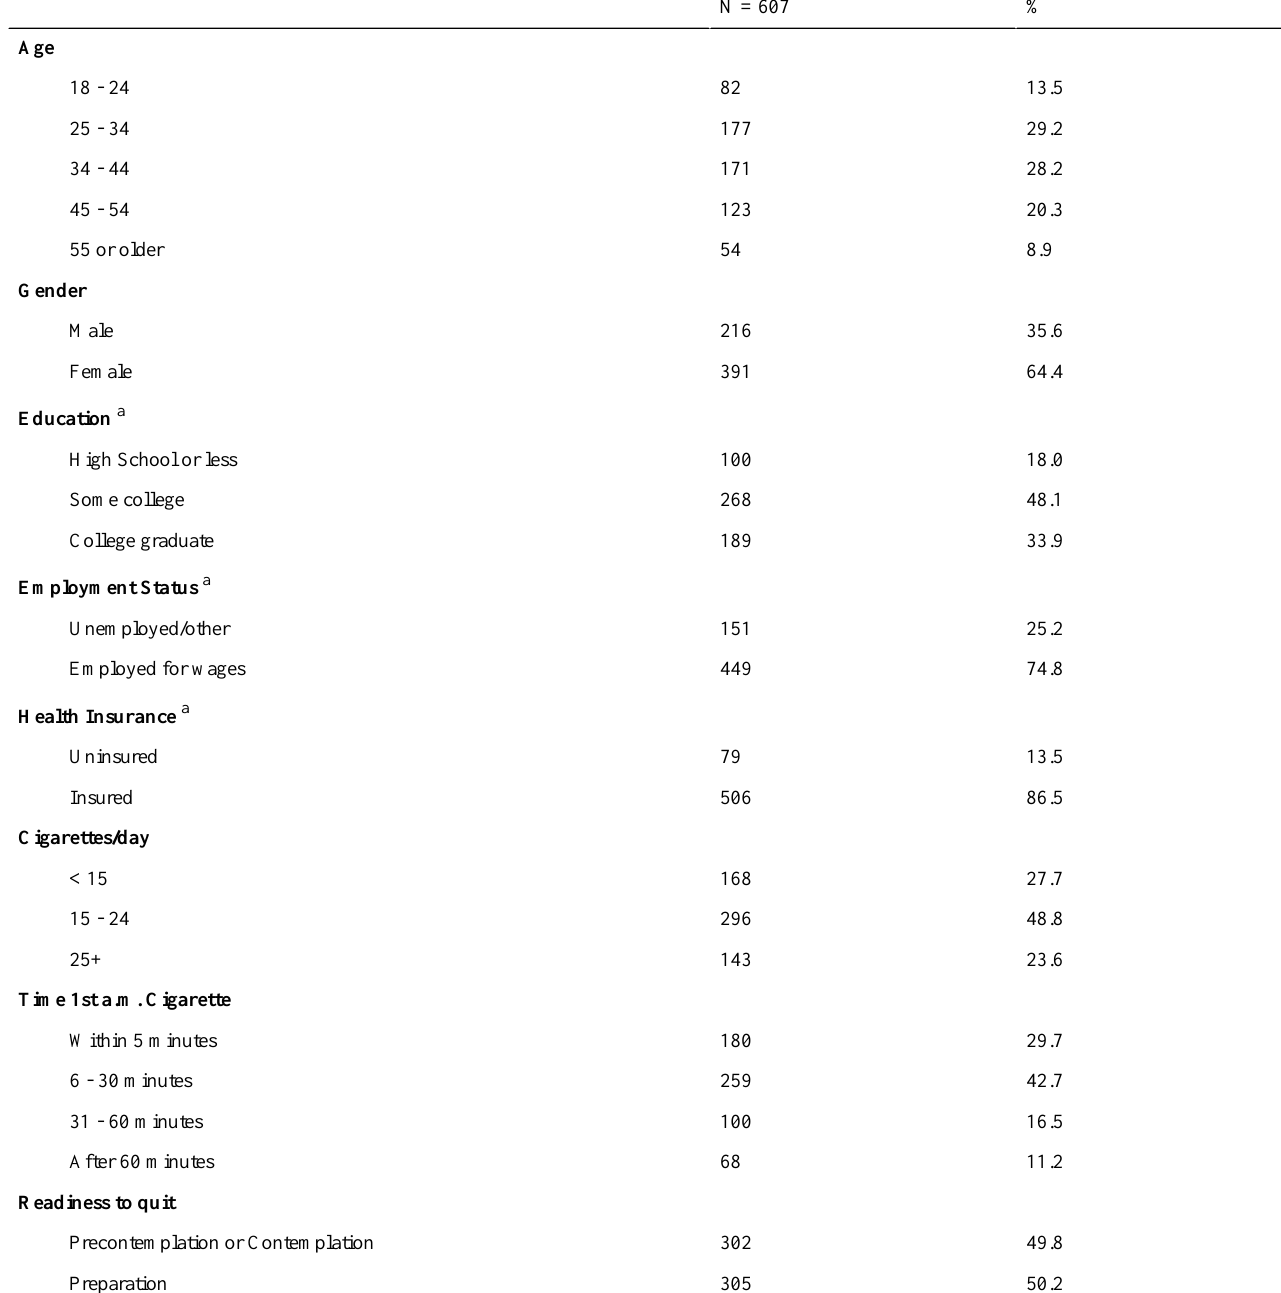
Table 1. Participant